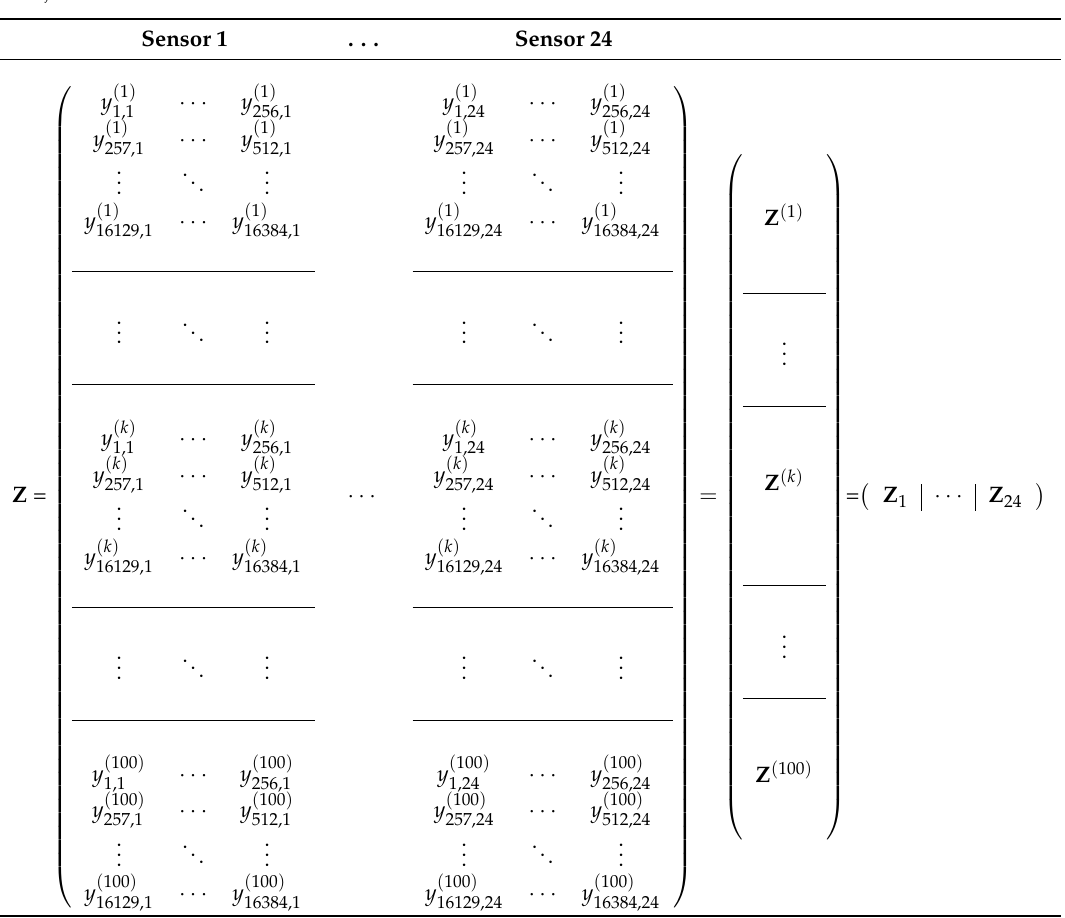
Table 2. Data reshaping. On the one hand, this process can be viewed as the vertical stacking of K = 100 matrices Z ( k ) , k = 1, . . . , K , where each matrix is associated with a different experiment. On the other hand, this process can also be viewed as the horizontal concatenation of J = 24 matrices, Z j , j = 1, . . . , J , where each matrix is associated with a different